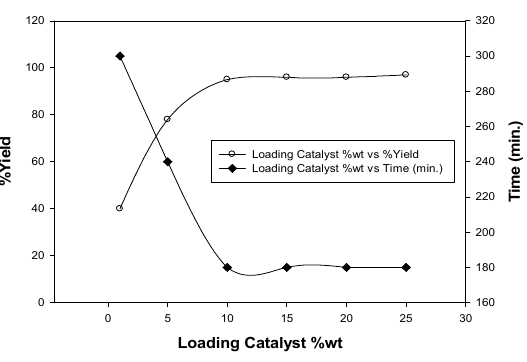
Figure 5. Optimization of the chitosan graft copolymer as basic catalyst.